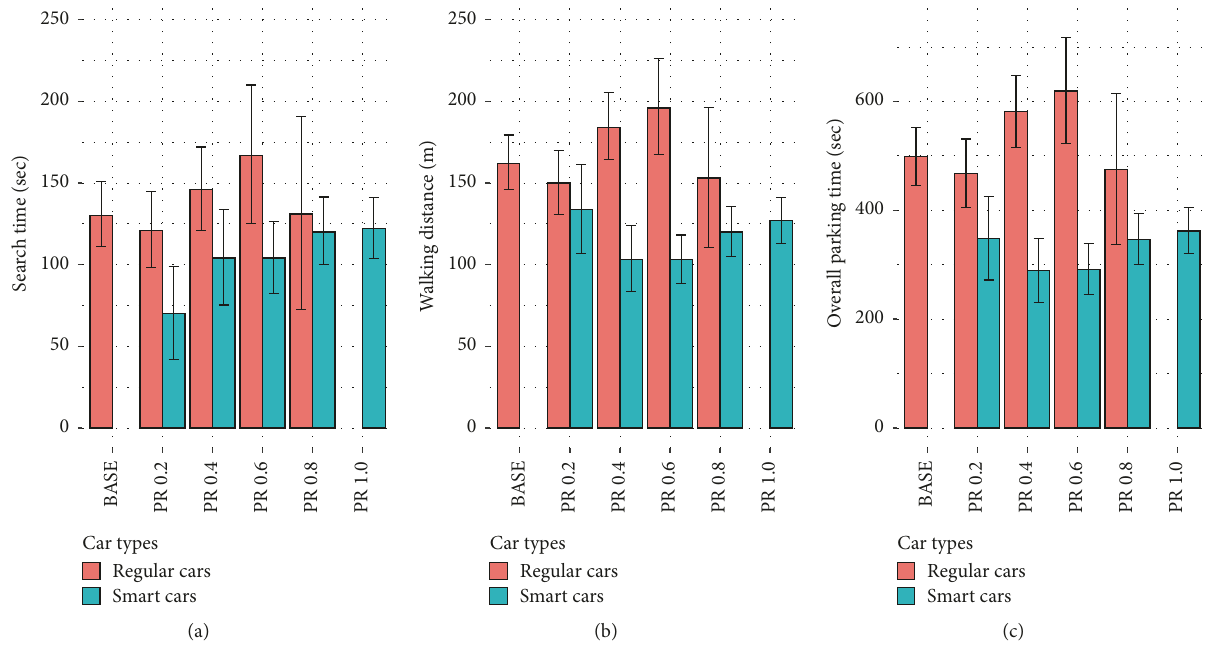
Figure 8: Results for individual drivers for on-street parking in high occupancy area only: (a) search time, (b) walking distance, and (c) total parking time, for regular cars and smart cars, for a 95% confidence interval at afternoon peak hours.